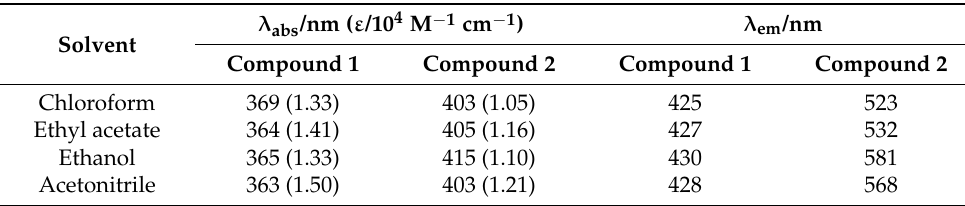
Figure 4. ( A ) Absorption spectra of 1 × 10 − 5 M solutions of compound 2 in ethyl acetate, acetonitrile, chloroform, and ethanol. ( B ) Normalized fluorescence spectra ( λ exc = 420 nm) of 1 × 10 − 6 M solutions of compound 2 in the same solvents. Table 2. Maximum absorption ( λ abs ) and emission ( λ em ) wavelengths and molar absorption coeffi- cients ( ε ) for compounds 1 and 2 in several solvents.